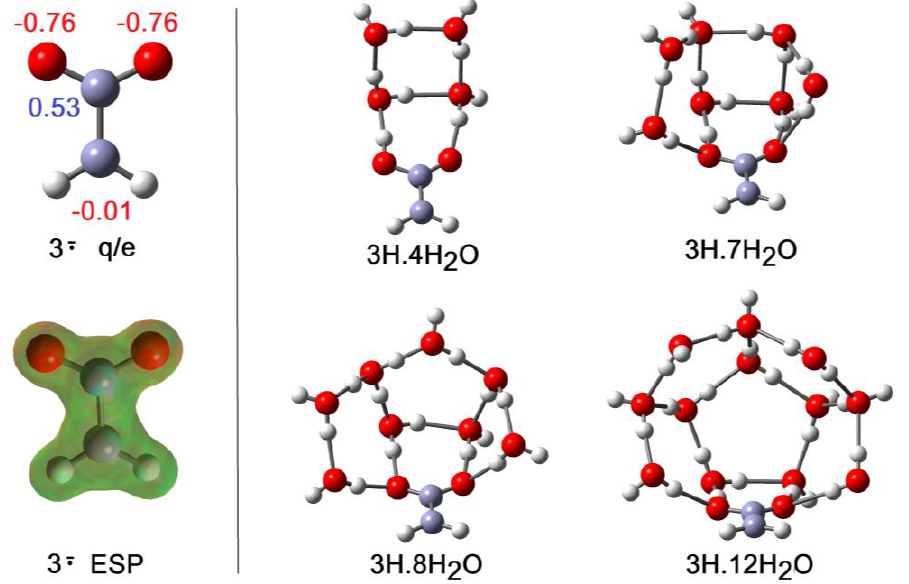
Figure 6. Optimized Structures of Hydration Clusters for Carboxy-methyl Radical 3H and Radical Anion 3 . Mulliken charges: negative in red, positive in blue.